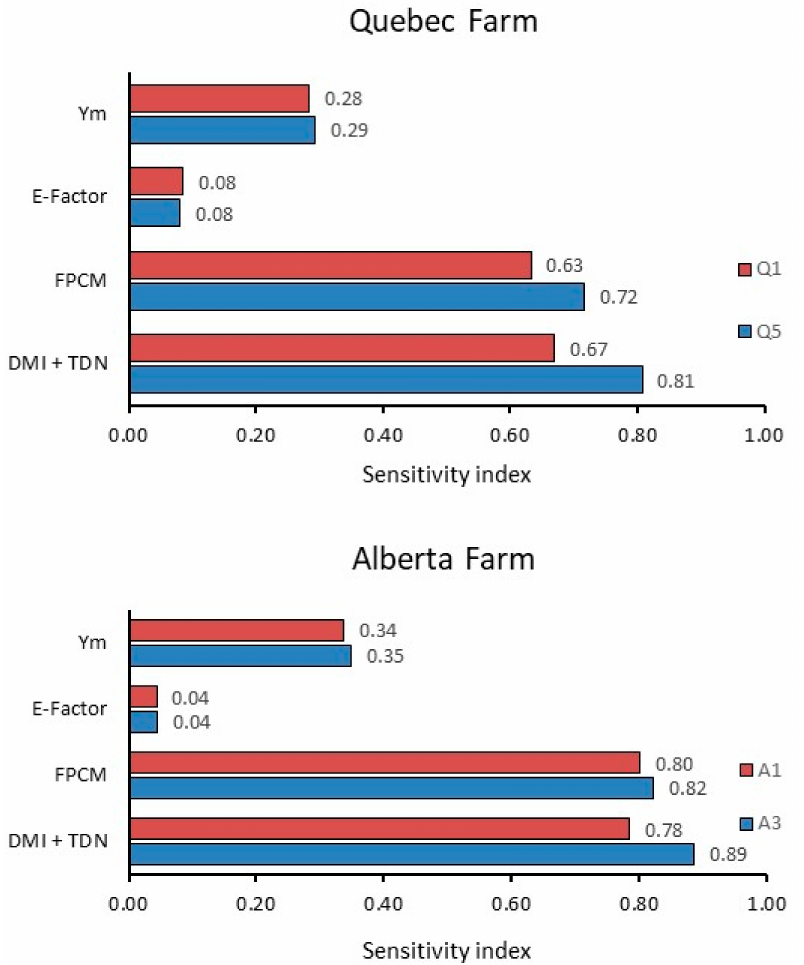
Figure 5. Sensitivity index showing the relative effect of input variables on the GHG intensity of FPCM for a Quebec (Q1, SBM from QC (local); Q5, CM from QC (local) without enteric CH 4 mitigation effect) and Alberta (A1, SBM from ON; and A3, CM from SK without enteric CH 4 mitigation effect) scenarios. An index near 0 indicates a minimal effect and an index near 1.0 means a large effect. The input variables were as follows: (1) decreased Y m value of the lactation diet, (2) decreased emission factors for imported SBM and CM, (3) increased FPCM production, and (4) decreased DMI of the lactating cows through increased total digestible nutrient content of